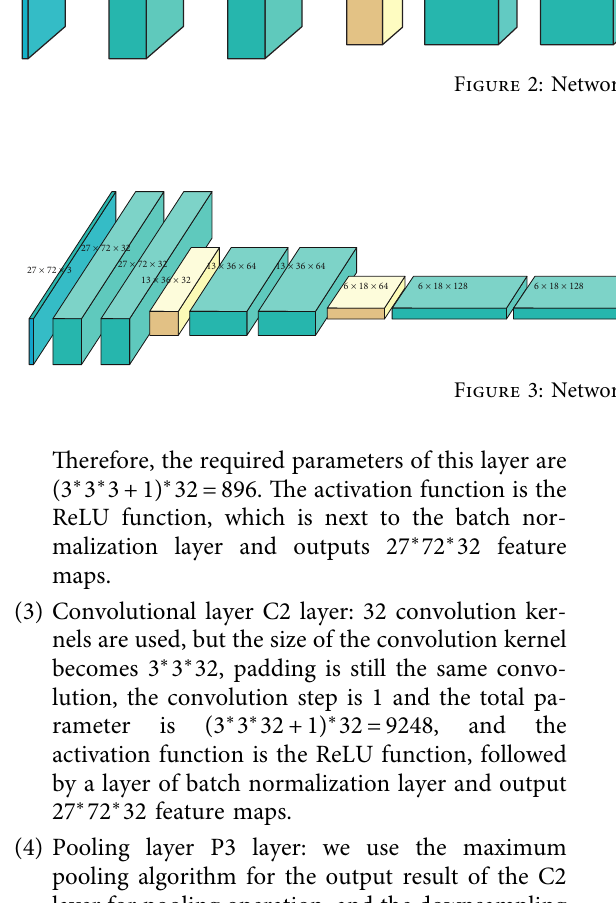
Figure 2: Network structure.